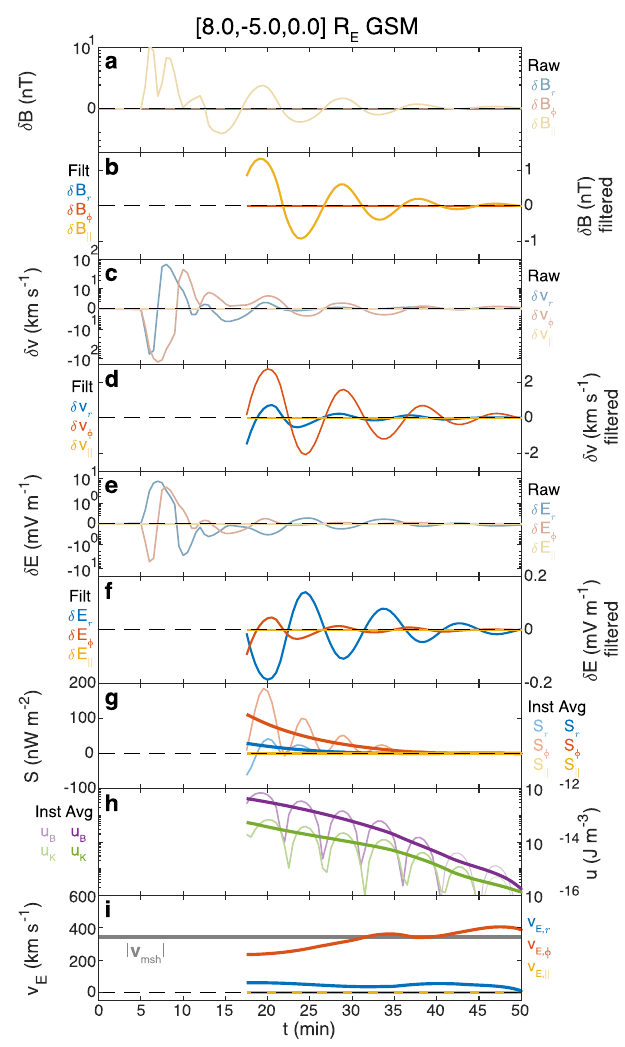
Fig. 6 Virtual spacecraft observations within MHD simulation. Displayed in a similar format to Fig. 1. From top to bottom the fi rst set of panels show perturbations in the magnetic ( a , b ), ion velocity ( c , d ) and electric ( e , f ) fi elds. In these vertical pairs, top panels show the raw data, whereas the bottom panels show the fi ltered data. Subsequent panels depict the Poynting vector ( g ) and energy density ( h ), showing instantaneous (thin) and time-averaged (thick) values. Finally, the energy velocity ( i ) is shown compared to the absolute magnetosheath fl ow speed (grey). Note the bi- symmetric log scale on panels a , c , e into the northern and southern tail lobes. The waves are thus con fi ned to closed magnetic fi eld lines, further backing the surface eigenmode interpretation.